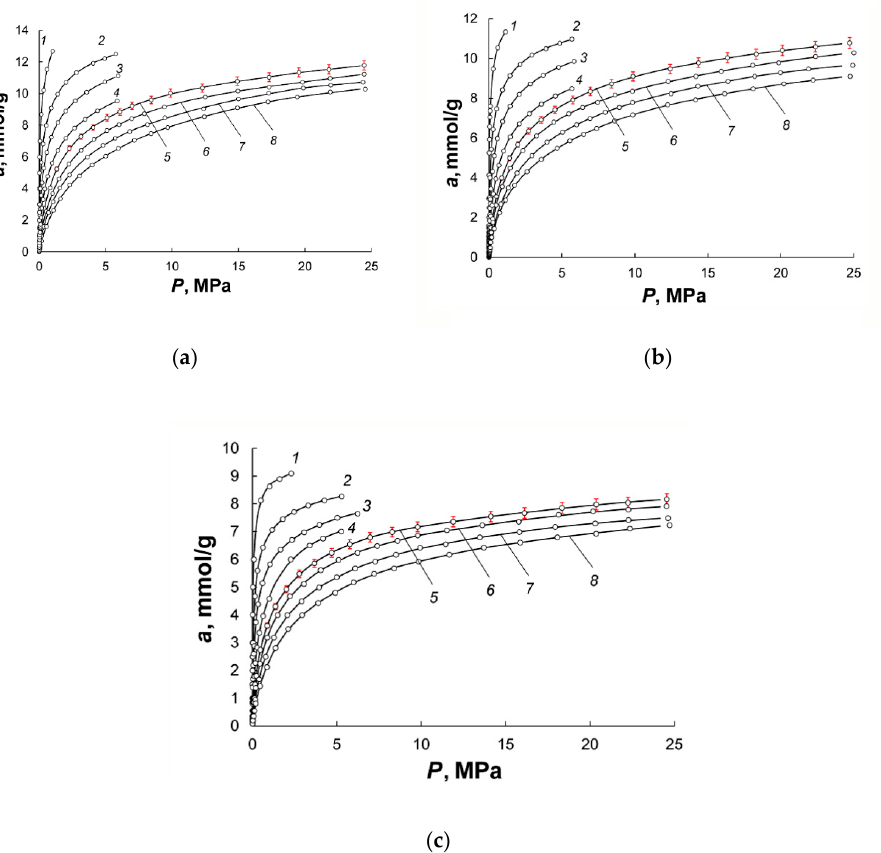
Figure 7. Methane uptake on AC-90S ( a ), AC-90L ( b ) and AC-60L ( c ) versus pressure at the temperatures, K: 178 (1); 216 (2); 243 (3); 273.15 (4); 300 (5); 320 (6); 340(7); 360 (8). Symbols show the experimental data; solid lines are the results of approximation by Equation (2). Error bars of 1.5% (5 Pa to 0.1 MPa), 3% (0.1–6 MPa) and 5% (6–25 MPa) are shown by red